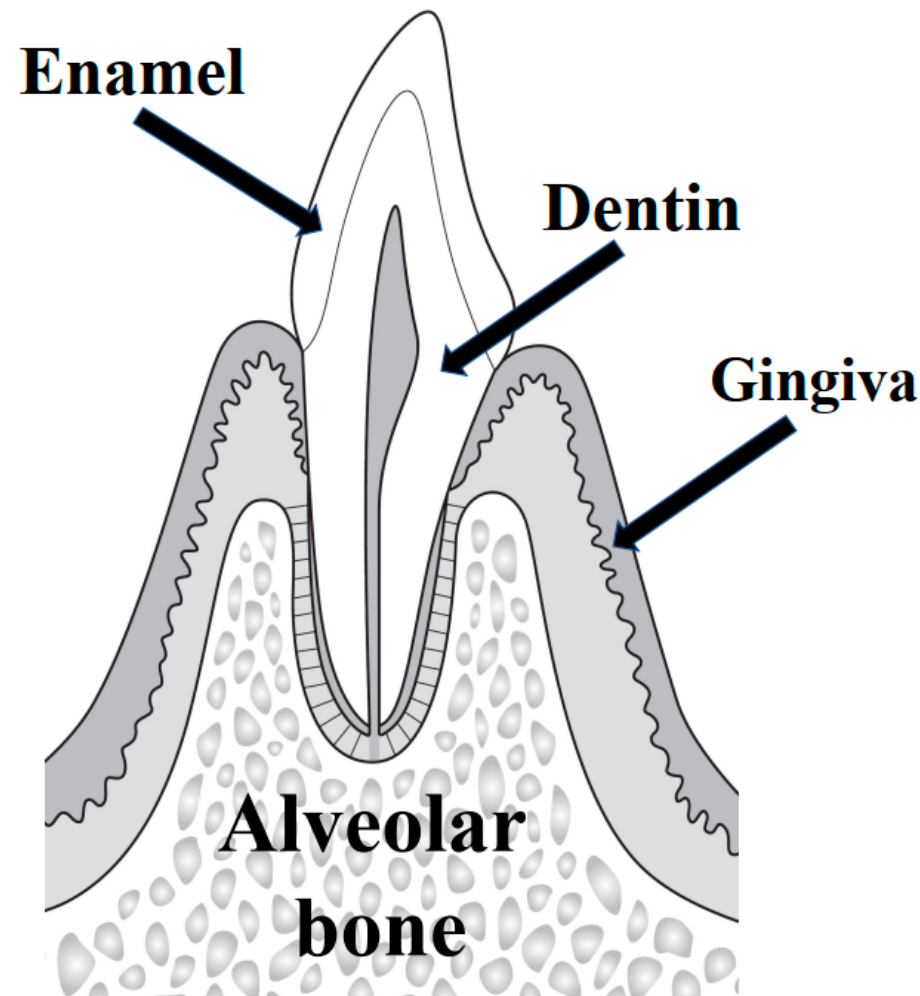
Figure 1. The alveolar bone. A diagram of a tooth cut vertically is shown. The alveolar bone is the bone that supports the tooth and is connected to the root of the tooth via the periodontal ligament, which receives the force of the bite. The outer surface is made of hard “dense bone,” while the inner surface is made of soft “trabecular bone,” and this outer frame and cushioning make it resistant to impact.